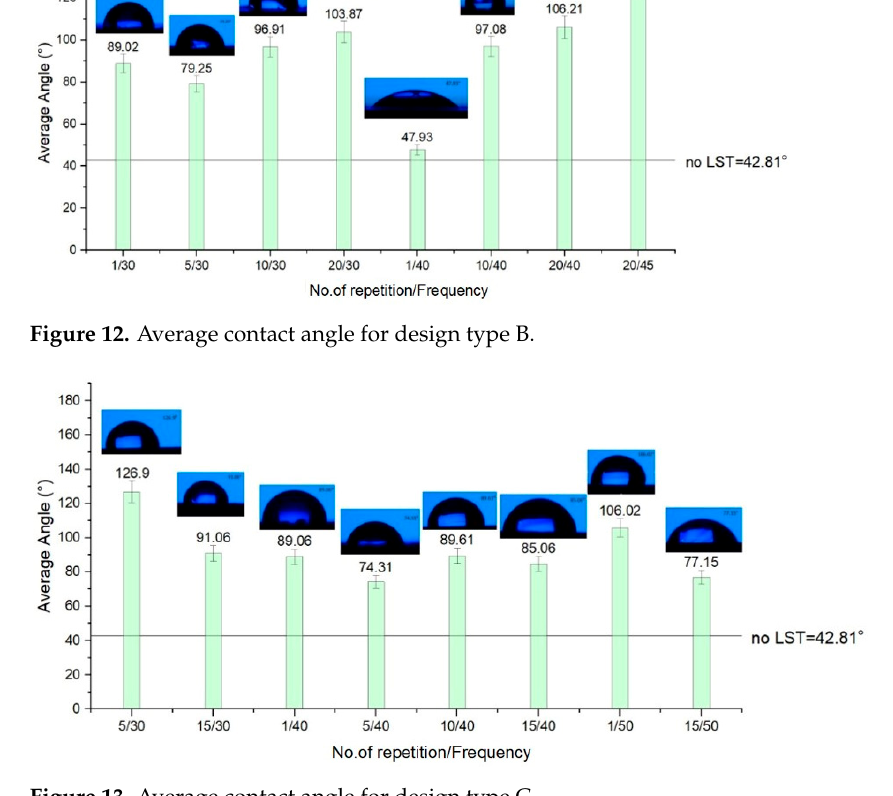
Figure 15. Aberration in contact angle measurement of the sample design type B (no. of repetition 10/frequency 40 kHz). The results of the wettability analysis of the micro textured areas offer a view on the influence of the number of repetitions and the frequency. As the number of repetitions increases, keeping the frequency constant, the measured CA increases, offering hydro- phobicity to the micro-structure’s surface, and a decrease in values of the CA occurs as the frequency increases and the number of repetitions is constant. For a speed of 300 mm/s, with 30 kHz frequency and five repetitions, and the pattern design type A (CA = 92.76°) and type C (CA = 126.9°), the wettability measurement offers hydrophobic surfaces (CA >